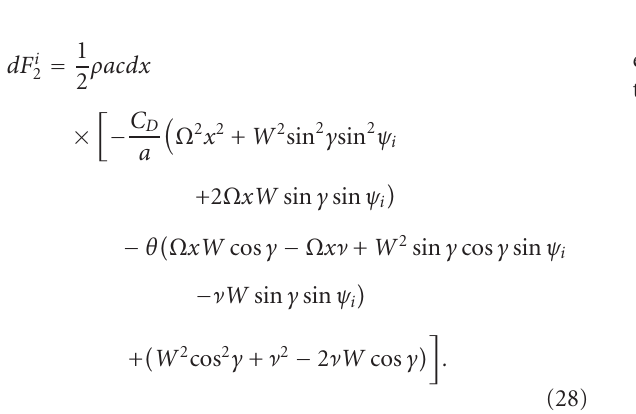
Figure 14: (a) C P versus J for θ = 0 ◦ and γ = 15 ◦ and (b) C P versus J for θ = 0 ◦ and γ = 60 ◦